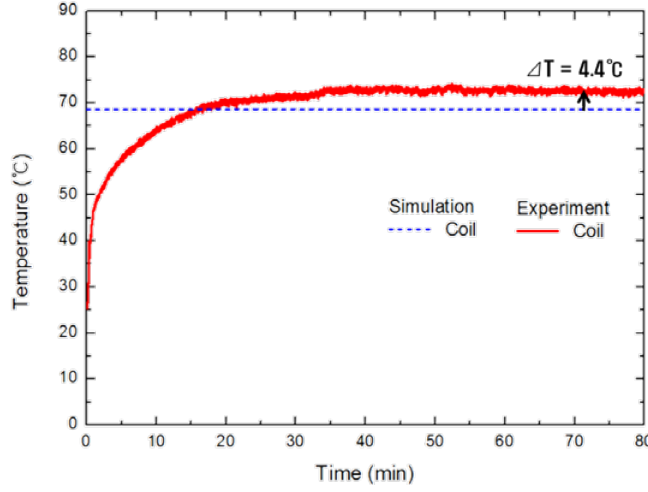
Figure 11. Verification of analysis and experimental results at an increased temperature of 48